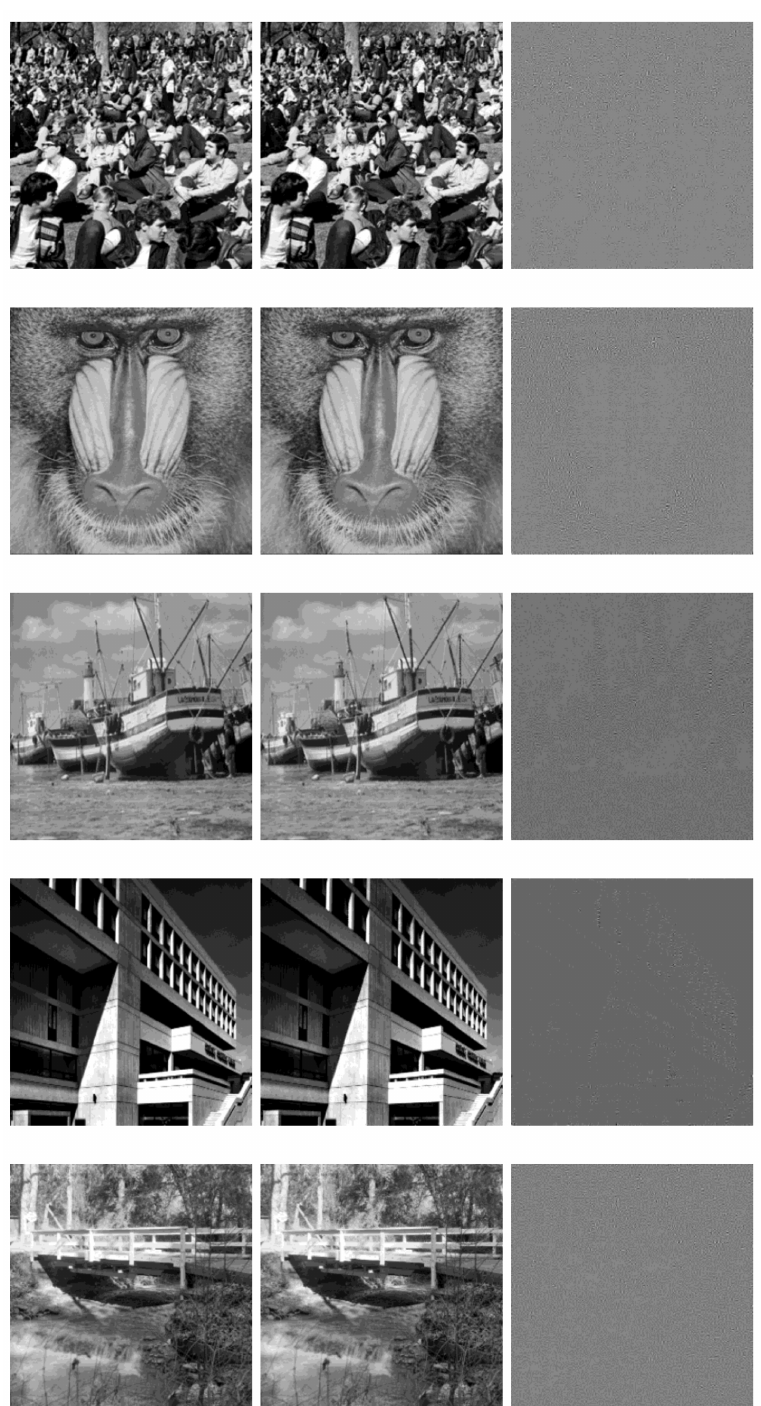
Figure 3. Original, watermarked and difference images by the proposed method: Fingerprint, Lena, Barbara, Crowd, Mandrill, Boat, Mit and Bridge. In each image, the left part, middle part and the right part are represented the original image, the watermarked image, and the absolute difference between the watermarked and the original image,